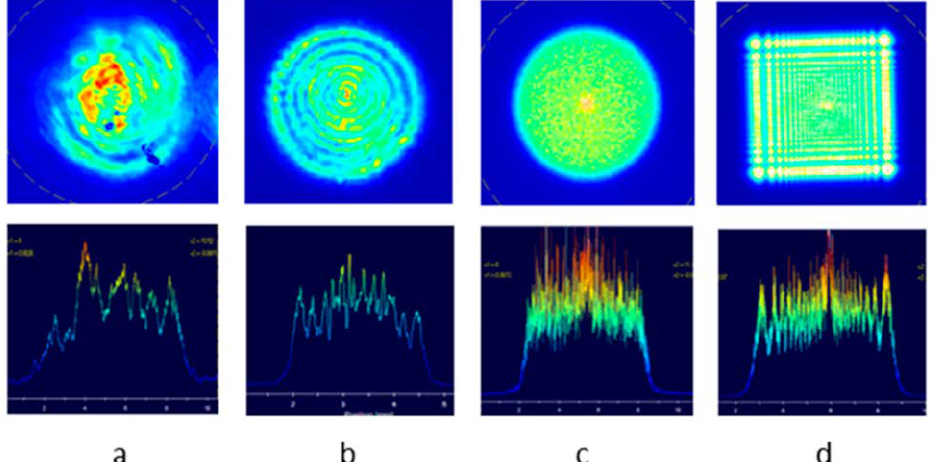
Figure 9. Two-dimensional pump beam patterns (upper row) and w-profiles (lower row) of mul- timode laser ( a ), singlemode laser ( b ), after homogenization of multimode laser by DD ( c ) and by MLA ( d ). Spot size at ( b ) is 3 mm, and at other patterns is 6 mm. Adopted with permission from ref. [17,18]. Copyright 2019 © The Optical